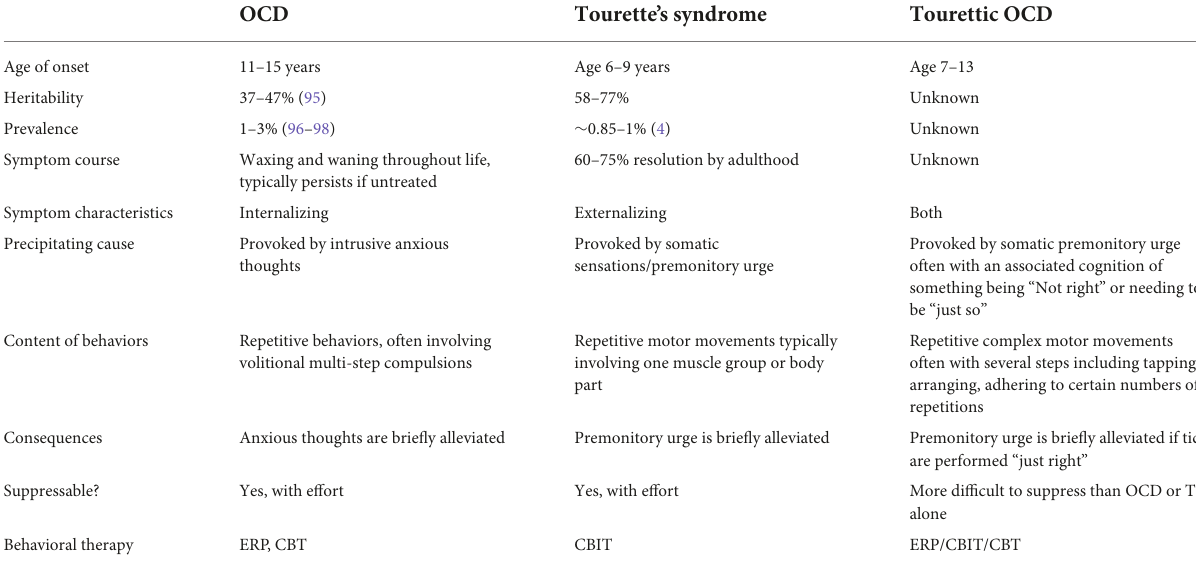
TABLE 1 Comparative characteristics of OCD, Tourette’s syndrome, and Tourettic